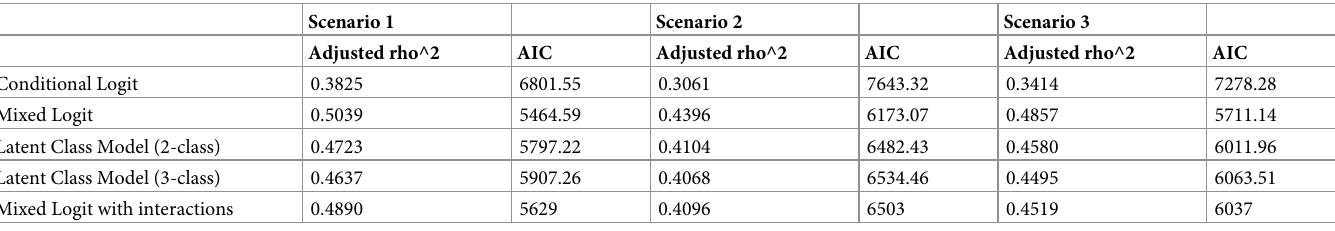
Table 3. Model fit